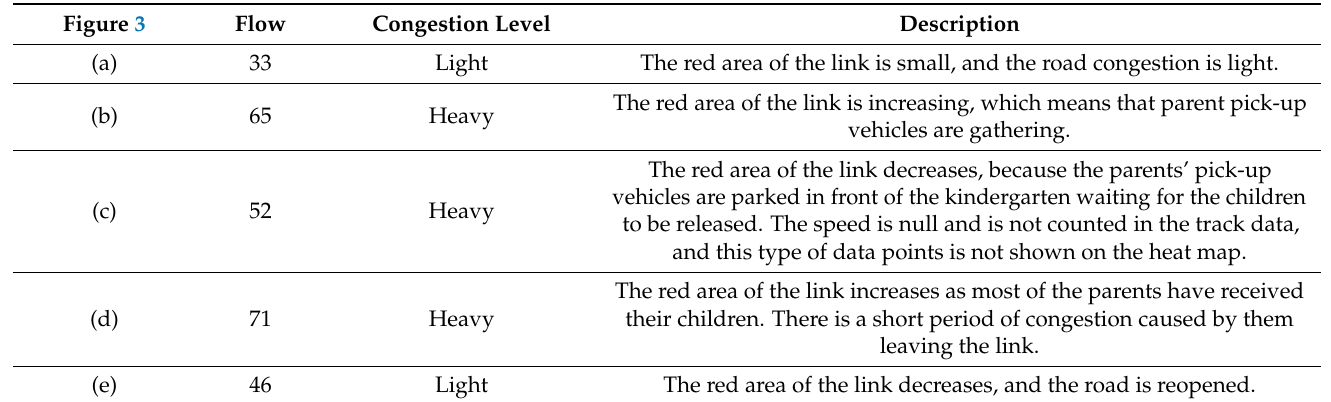
Table 1. Description table of heat map of peak hour traffic flow on the link where POI is located. Figure 3 Flow Congestion Level Description